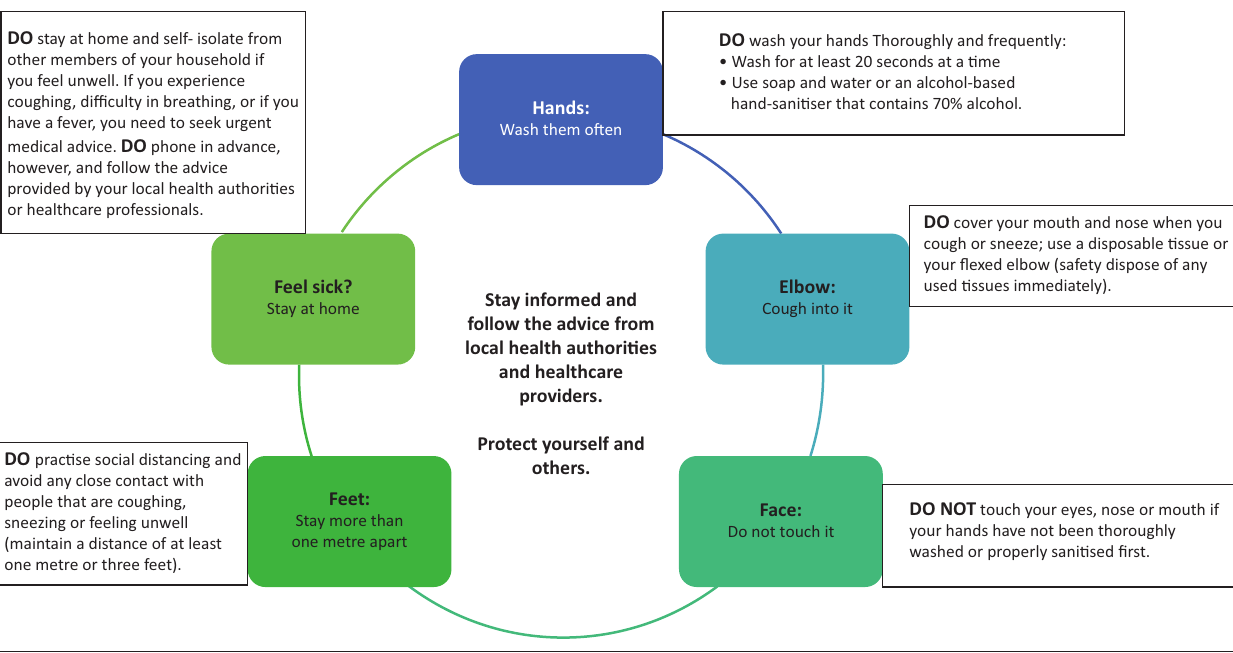
FIGURE 1: The most important preventative measures in the fight against COVID-19.